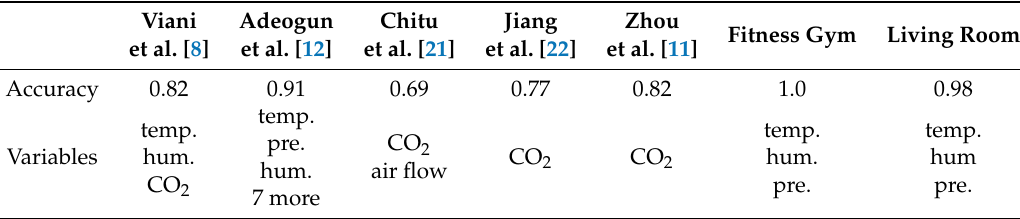
Table 9. Comparison of best results with results in the related